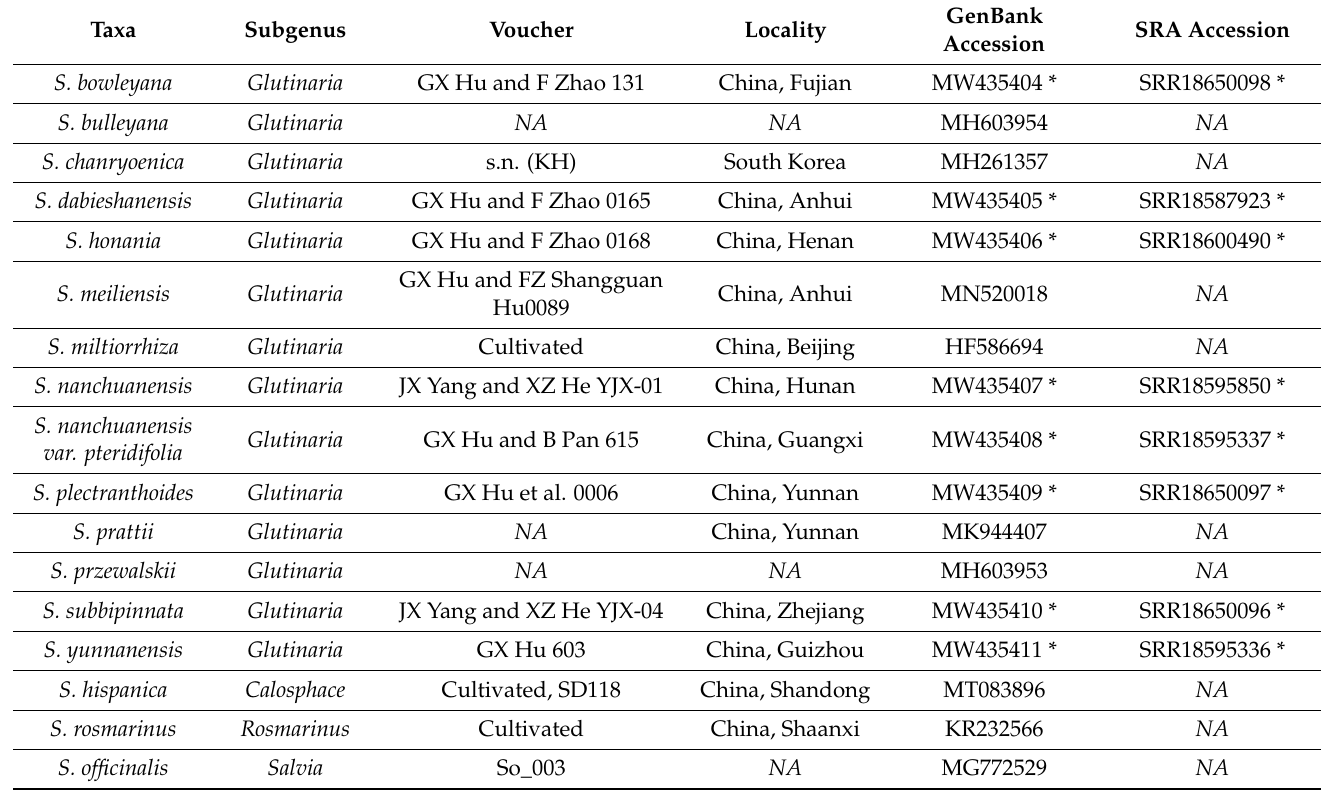
Table 1. Voucher information and GenBank and SRA accession numbers for taxa used in this